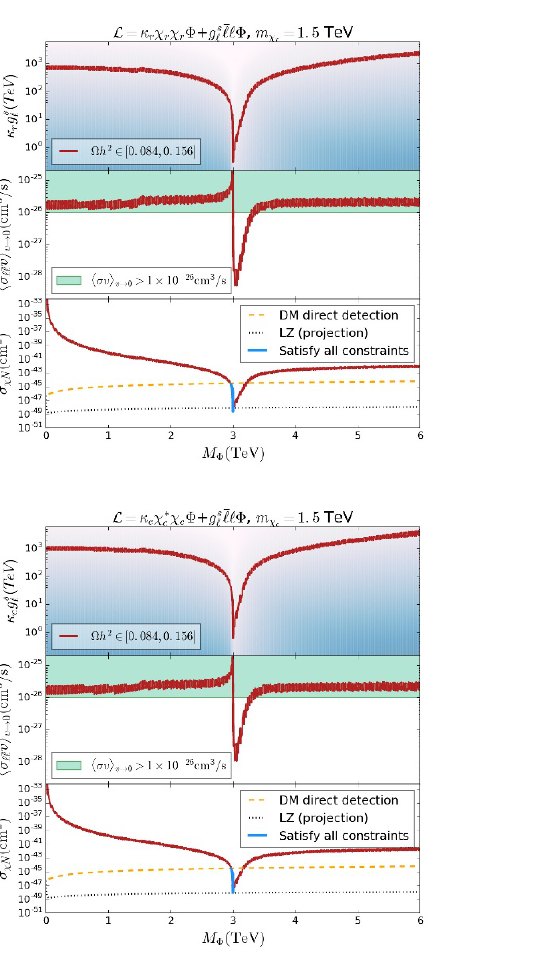
Figure 1 . A scalar mediator scalar coupled to real scalar DM (top) and complex scalar DM (bottom). The mediator coupling with leptons is scalar (left) or pseudoscalar (right). Each panel shows DM properties as a function of mediator mass. The blue color gradient in the (cid:12)rst panel shows relic density, where darker blue means greater relic